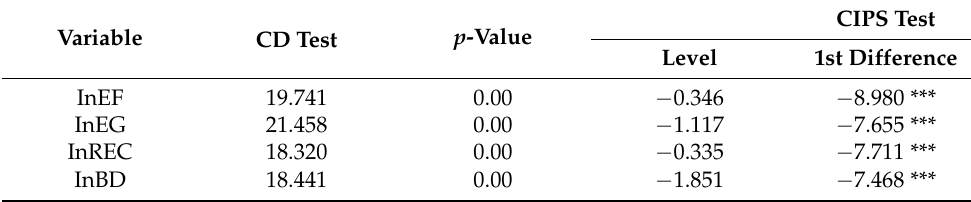
Table 4. The findings of CD and CIPS unit root tests.